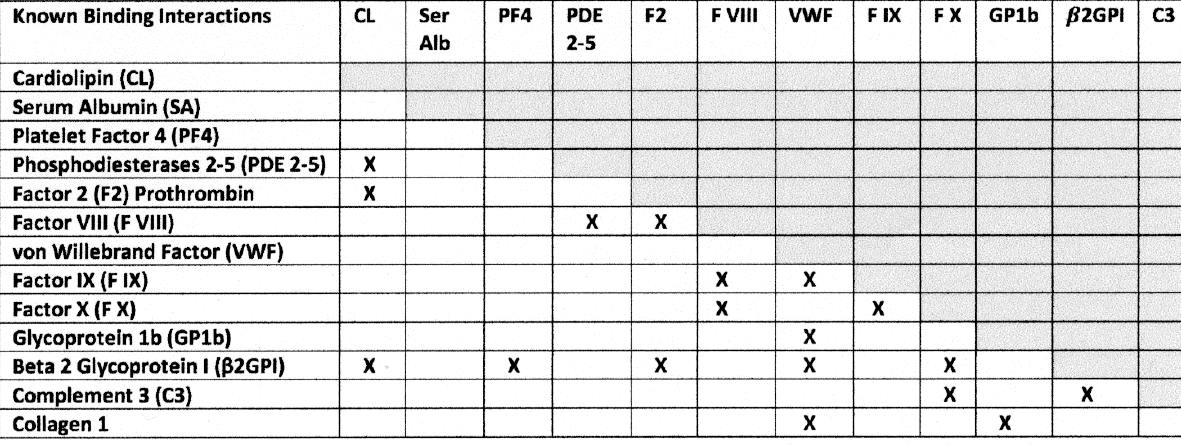
Figure 10. Summary of known binding interactions between proteins involved in the coagulation path- way. See text (Section 2.4) for references. CL = cardiolipin; Ser Alb = serum albumin; PF4 = platelet factor 4; PDE = phosphodiesterase; F2 = factor 2; FVIII = factor VIII; vWF = von Willebrand Factor; FIX = factor IX; FX = factor X; GP1b = glycoprotein 1b; β 2GPI = beta 2 glycoprotein I; C3 = complement C3.